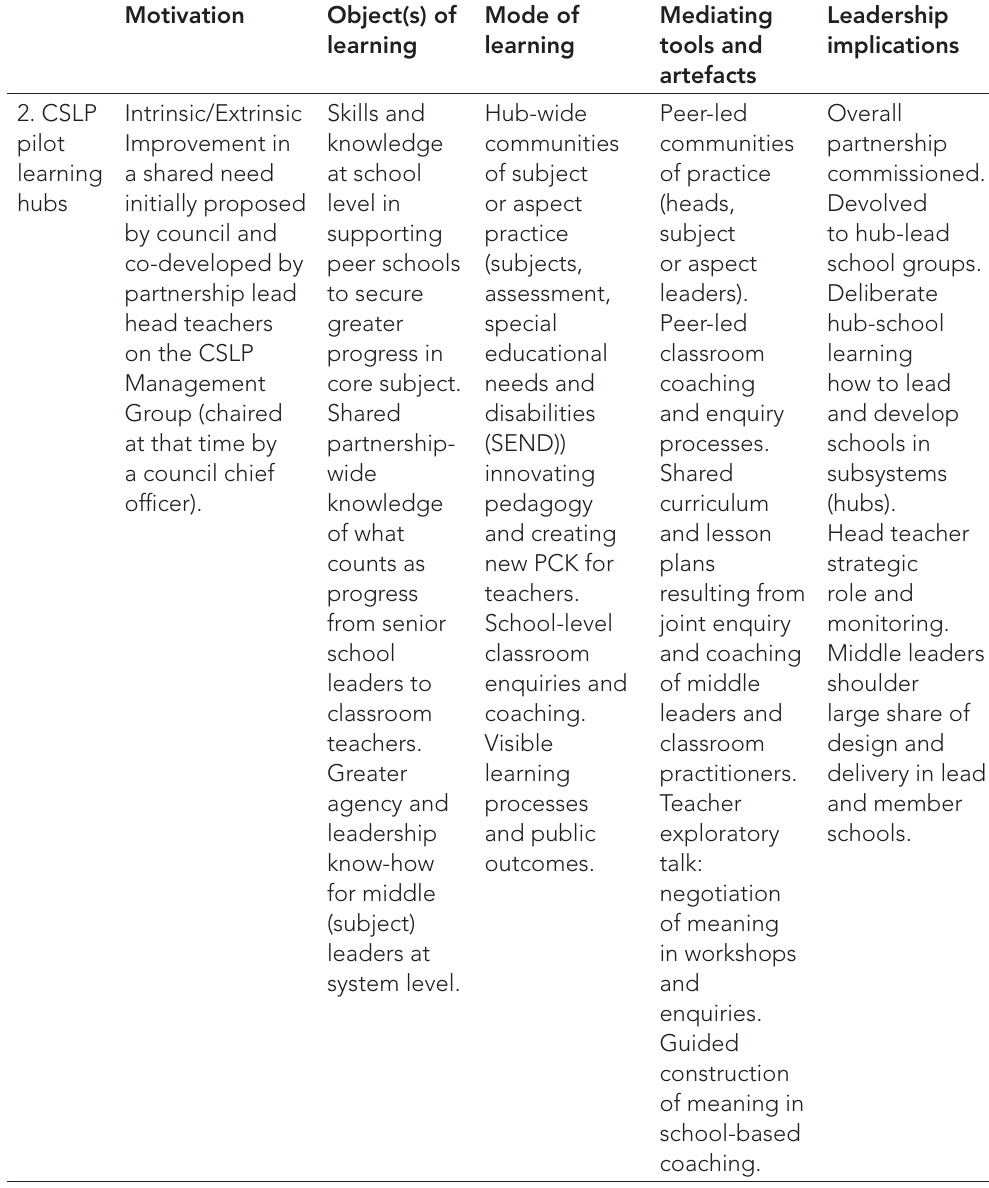
Table 2: Sociocultural classroom-, school- and system-level professional learning model – Stage